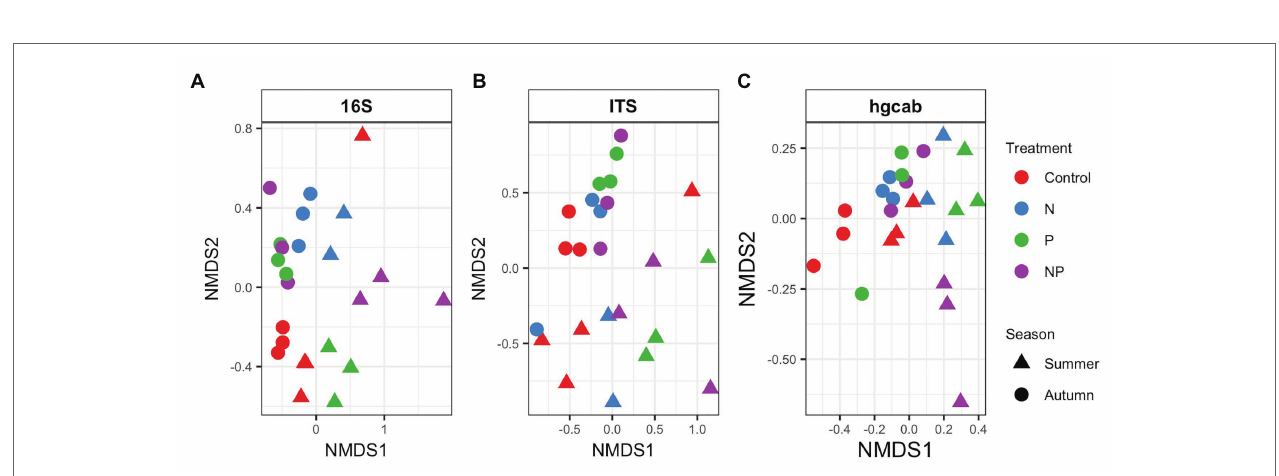
FIGURE 5 | NMDS of Bray-Curtis dissimilarity of (A) bacteria/archaea (16S rRNA), (B) fungi (ITS), and (C) mercury methylating ( hgcAB ) periphyton communities of control, nitrate (N), phosphate (P), and nitrate + phosphate (NP) nutrient exposures in summer and autumn experiments. Color represents treatment while shape indicates the season periphyton was